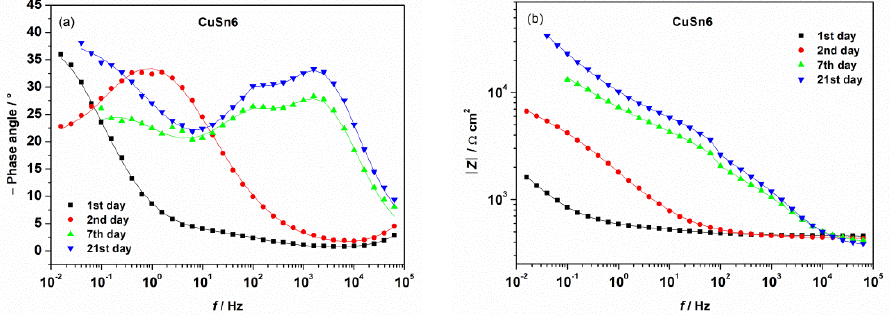
Figure 3. EIS spectra for CuSn6 for continuous immersion in simulated acid rain at pH 5. ( a ) Bode phase angle; ( b ) Bode impedance.